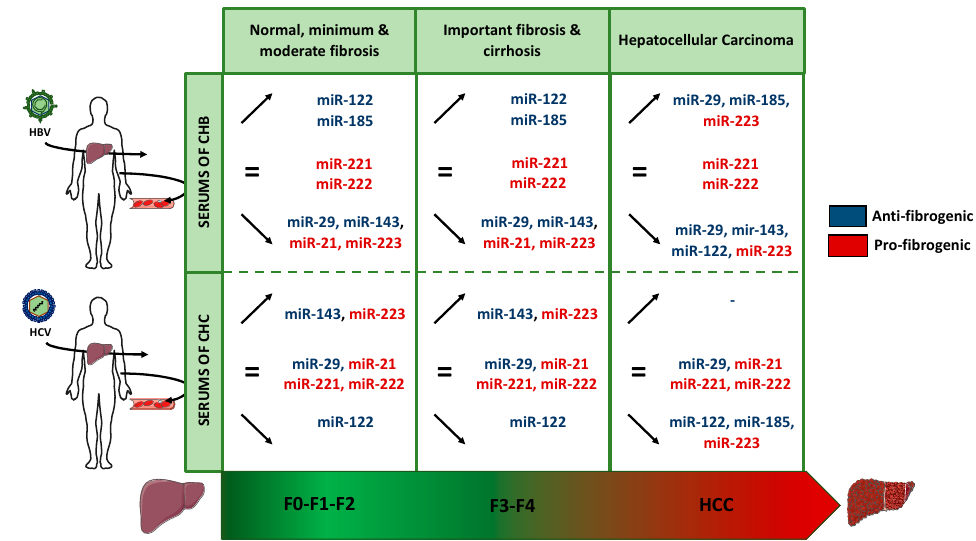
Figure 5. miRNAs dysregulated during fibrosis progression and HCC development in HBV and HCV infections. Expression increase ( ↑ ) decrease ( ↓ ) or its equal (=) during the two different mean stages of fibrosis progression mild and moderate fibrosis (F0 to F2), advanced fibrosis and cirrhosis (F3–F4) and HCC. The miRNA function as anti-fibrogenic and pro-fibrogenic is marked by blue and red color respectively.